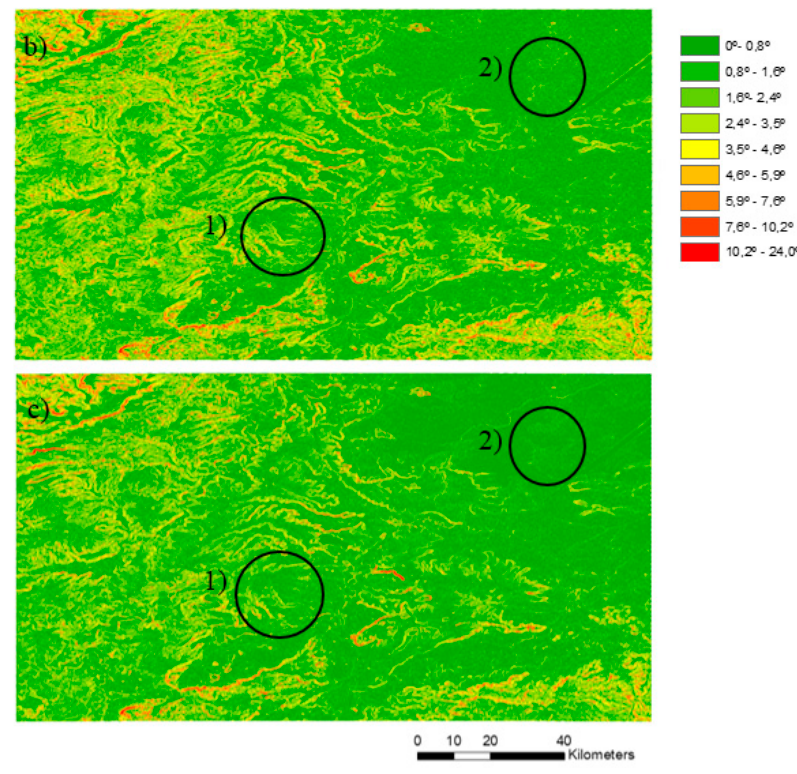
Figure 17. Slope of the study area derived from: ( a ) the Ordnance Survey reference DEM, ( b ) the original SRTM 30, and ( c ) rebuilt DEM using rivers and streams. The black circles 1) and 2) highlight regions where differences between maps can be observed.